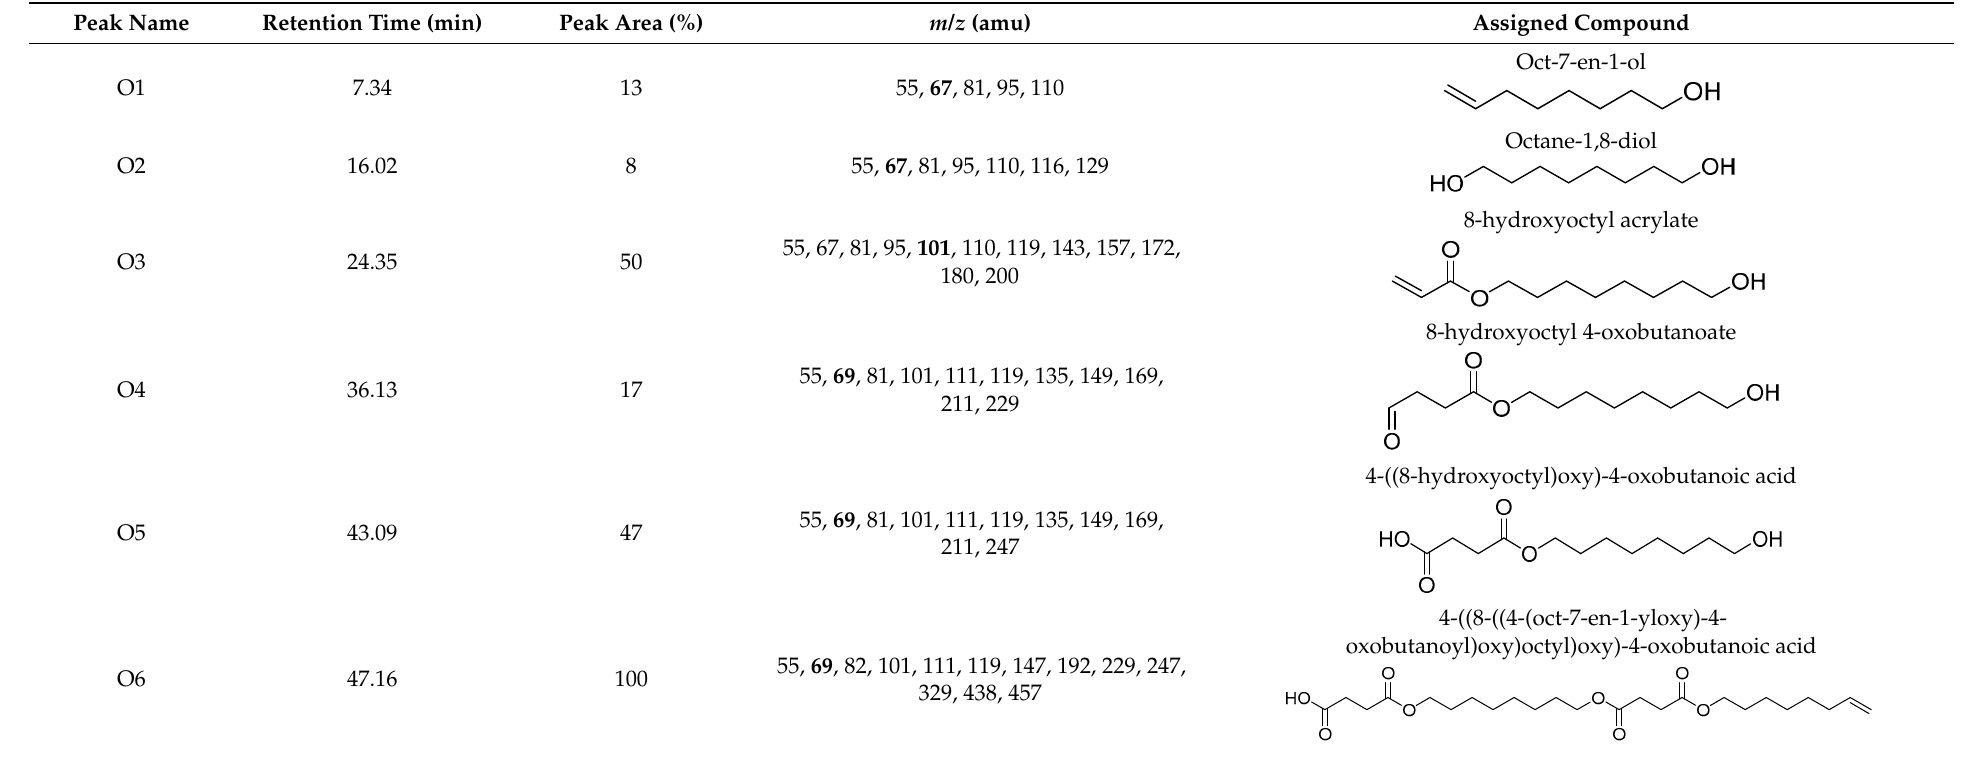
Figure 5. Mass spectra of the major decomposition products of PHSu. Table 6. Thermal decomposition products of POSu. Table 6. Thermal decomposition products of POSu.